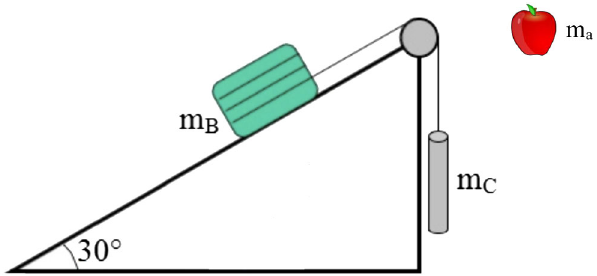
FIG. 6. Figure for paired problem for “ Newton ’ s second law ” tutorial.